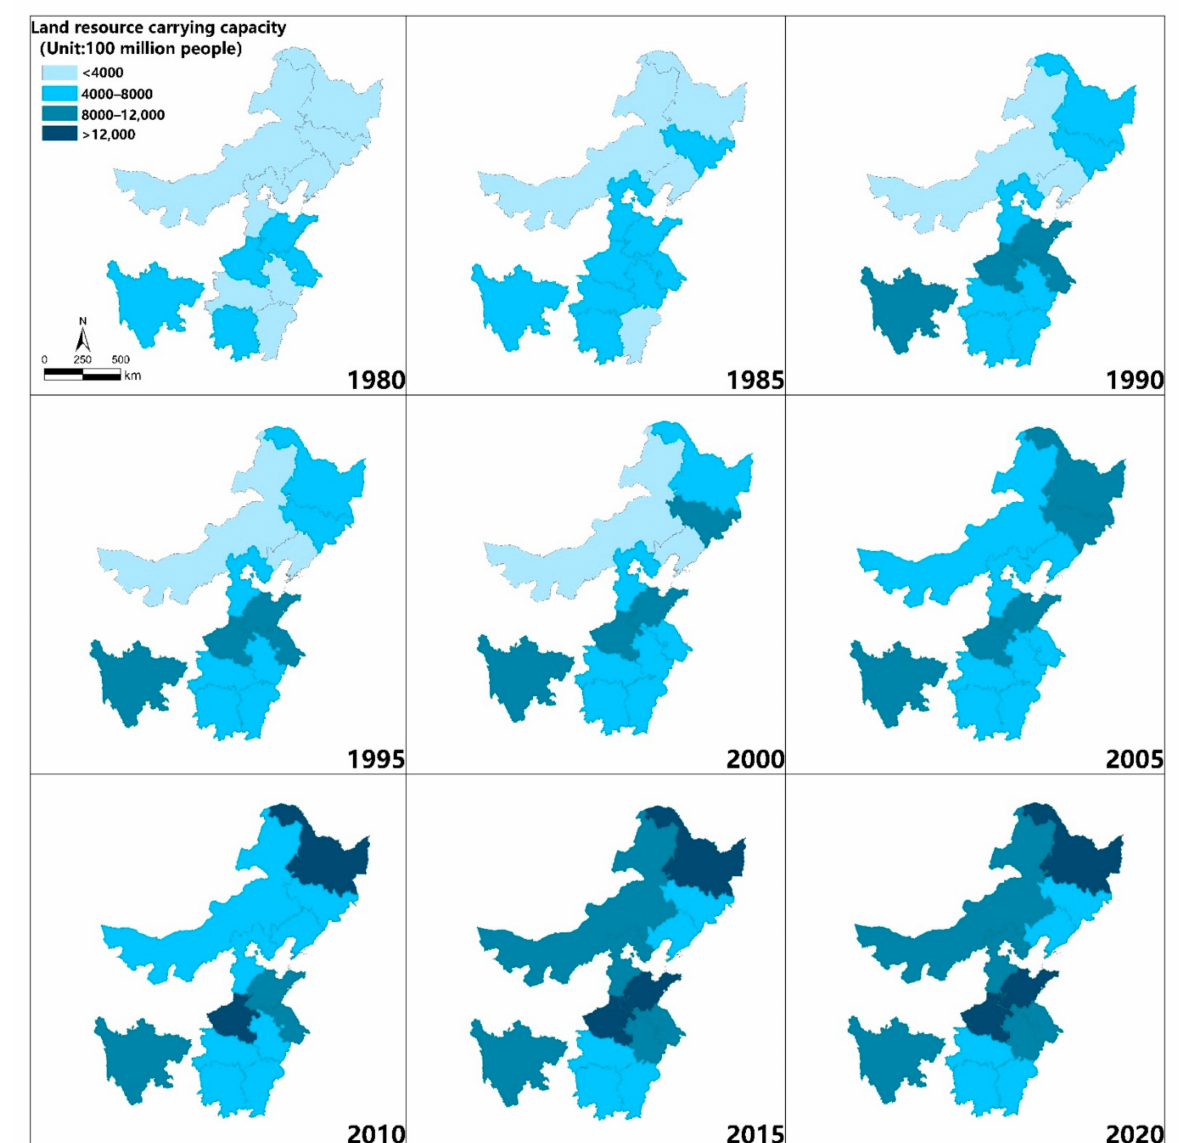
Figure 3. Spatial pattern of LRCC of China’s major grain-producing areas. As shown in Figures 3 and 4, the LRCC and the carrying state of land resources of the 13 provinces varied from province to province. As for the LRCC, it shows a year-by-year increasing trend on the whole. The LRCC in Northeast China and some provinces in the middle and lower reaches of the Yangtze River significantly improved. At all levels, the overall gap of the LRCCI of each province is narrowing, but in the later 20 years, the gap widened, with the difference between the highest (Jiangxi Province) and the lowest (Heilongjiang Province) in 2020 being 0.833. The spatial evolution characteristics of LRCC and LRCCI demonstrate that an imbalanced development condition remains in the LRCC in major grain-producing